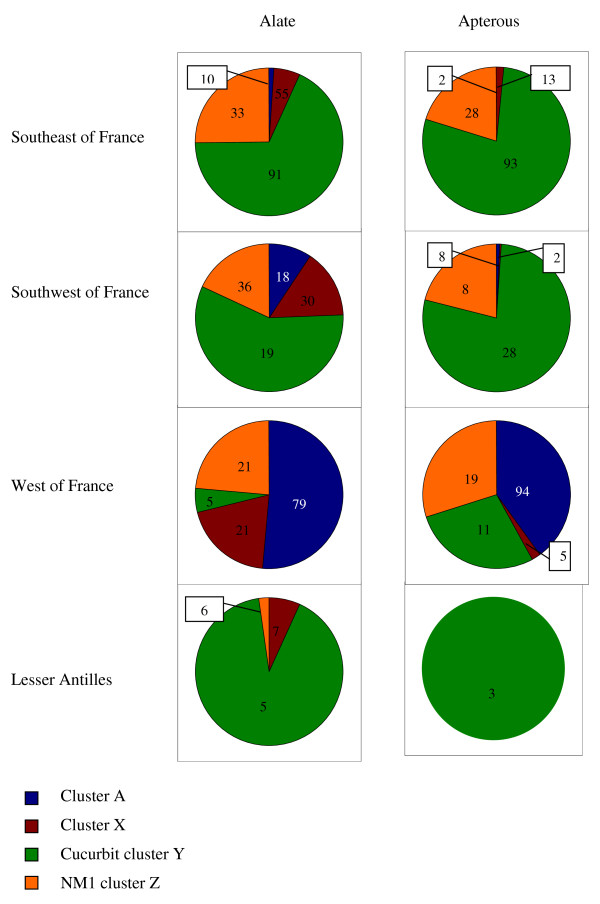
Distribution of the alate and apterous A. gossypii samples according to the genetic clusters. The proportion of individuals is represented by sectors and the numbers of multilocus genotypes is shown in each sector in the four melon-growing areas according to the division into four genetic clusters.